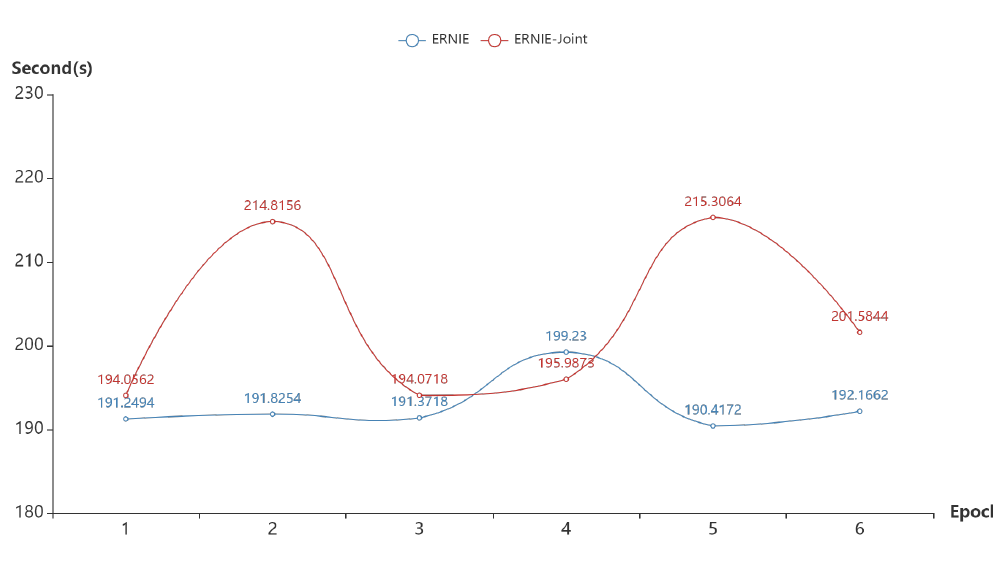
Figure 5. The running time of ERNIE-Joint and